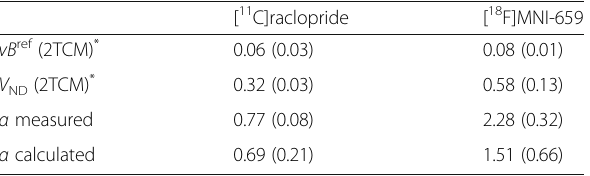
Table 1 Average (SD) across all subjects of parameter estimates for Eq. 11